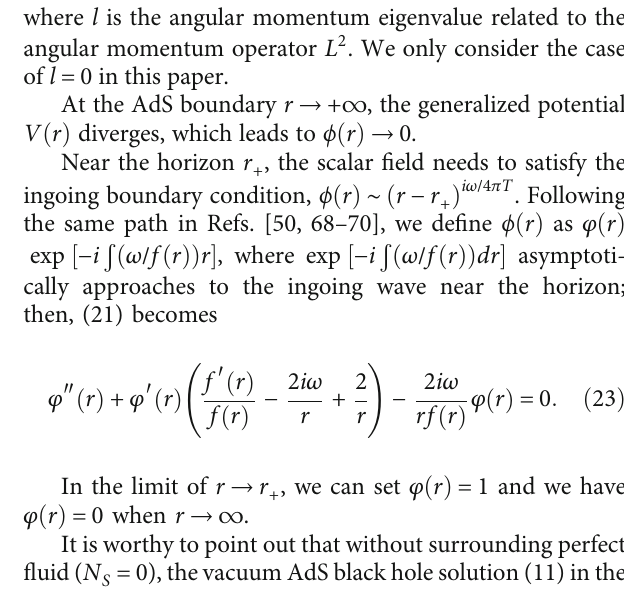
− T diagrams of four-dimensional AdS black holes with ψ = − 5/2 , N + and G